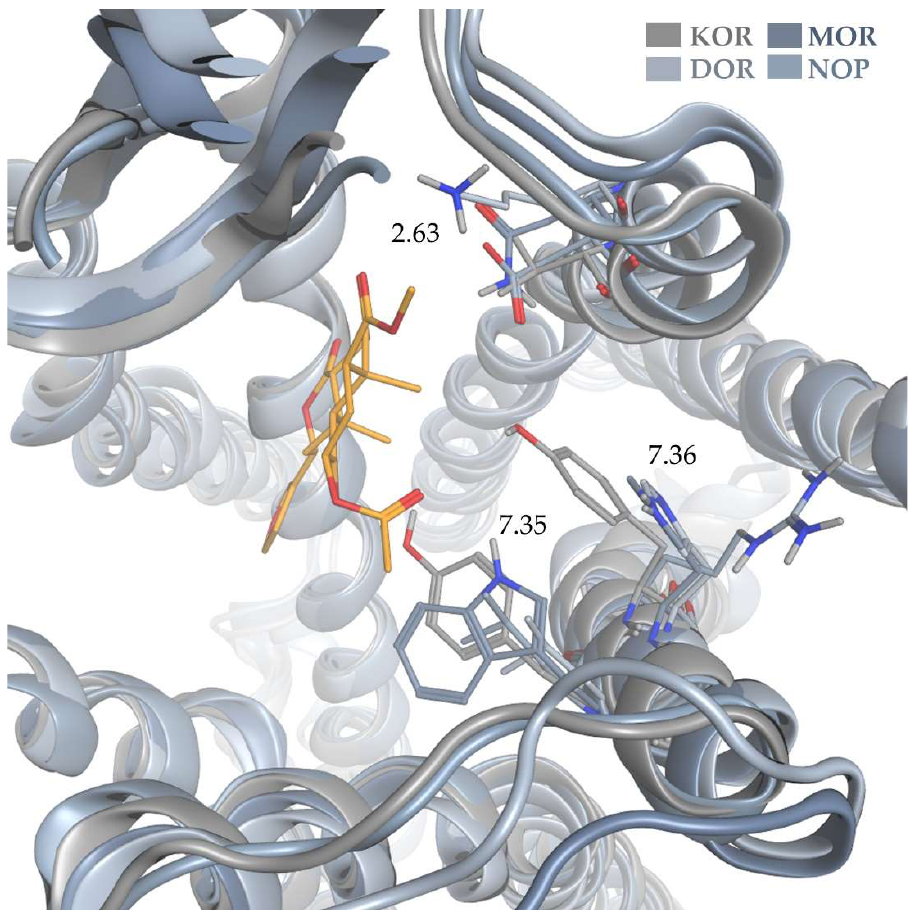
Figure 4. Superimposition of SalA bound to the KOR and the active-state crystal structures of MOR and DOR as well as the active-state homology model of NOP. and DOR as well as the active-state homology model of